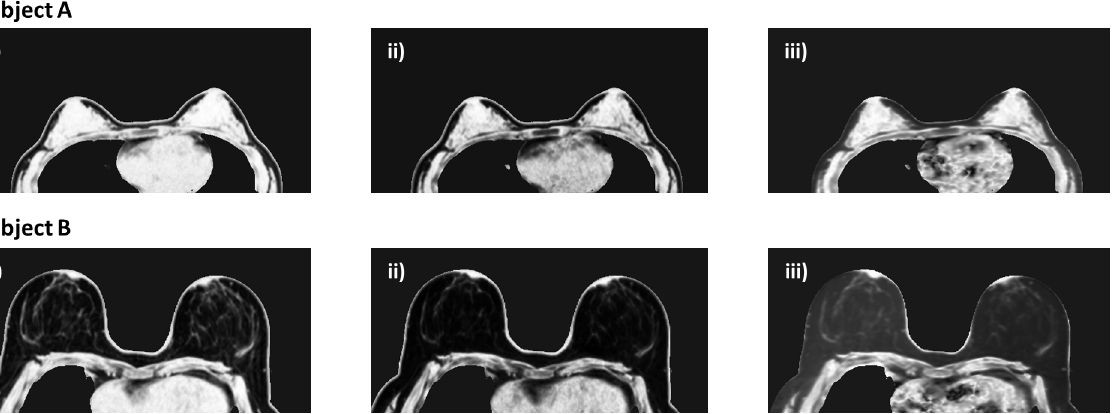
Fig 7. Low resolution water fraction images prior to signal correction for two subjects. A) a 26 year old volunteer with 64.6% FGT and B) a 50 year old volunteer with 18.4% FGT. GRE PD, GRE T 1 and SE T 1 -weighted images are shown in i), ii) and iii), respectively — the water fraction values within the fat are much higher in the SE T 1 -weighted